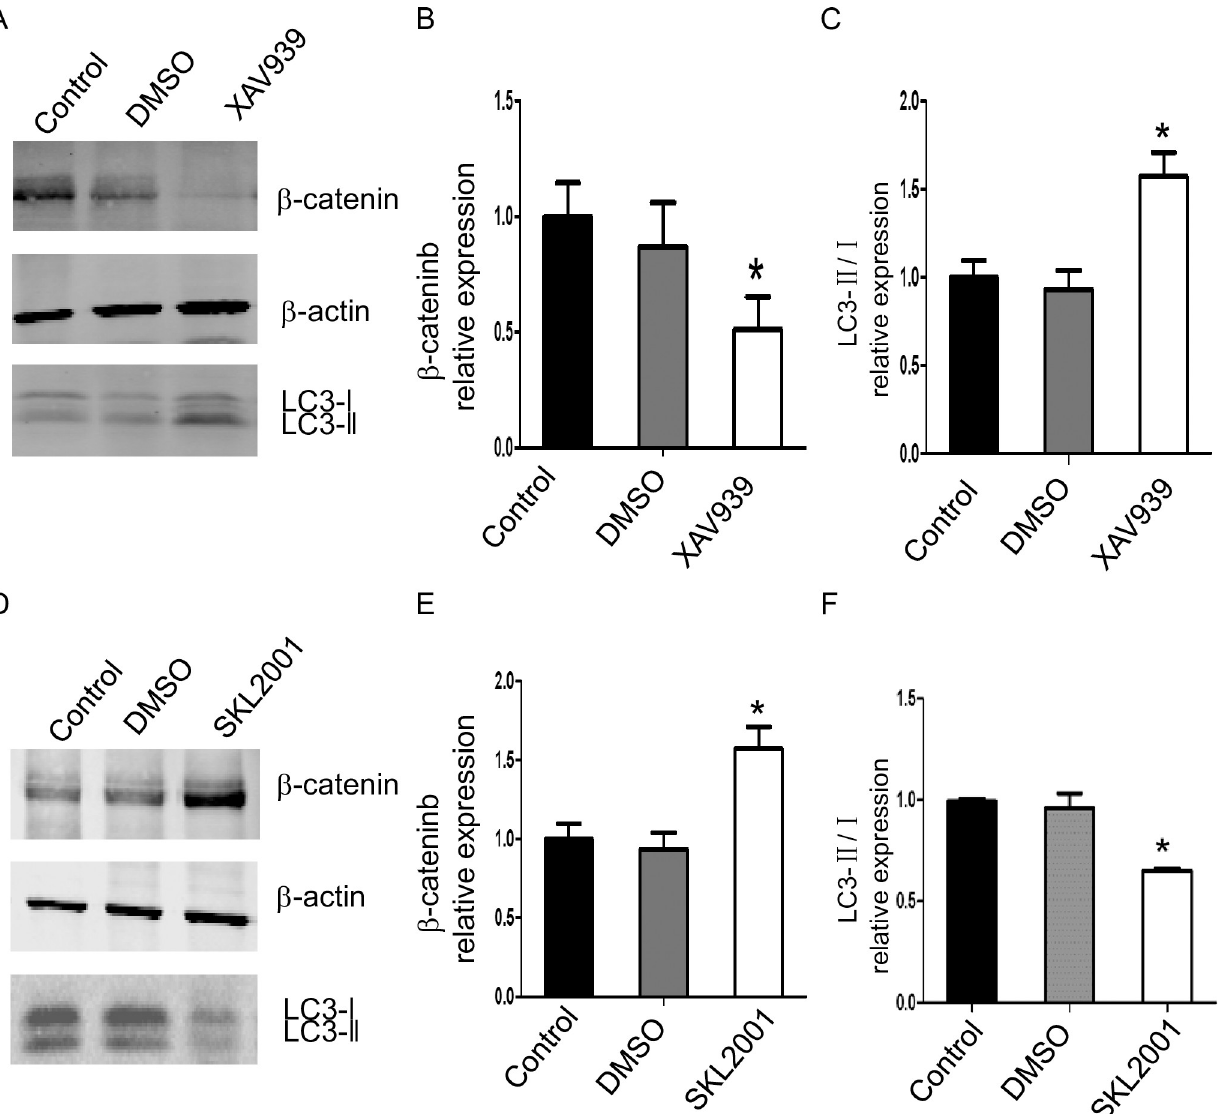
Fig 7. β -catenin inhibits autophagy in primary mouse hepatocytes. A, B, and C) Primary liver cells were treated with XAV939 or (D, E, and F) SKL2001 for 24 h and β -catenin and LC3 were detected by Western Blot and densitometric analysis. n = 3, data are presented as mean ± SD, � P <